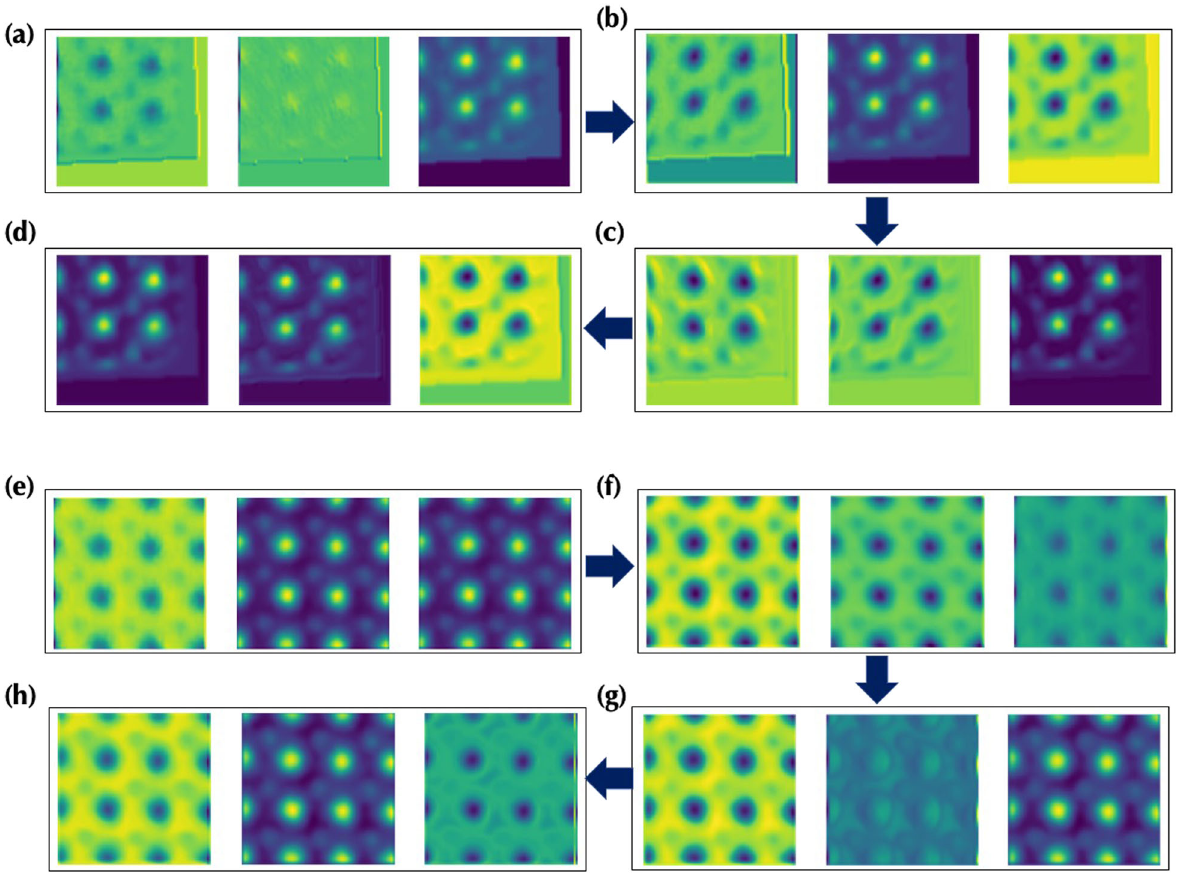
Fig. 5 Feature maps of CNN layers. Representative feature maps for three different fi lters of the fi rst four convolution layers of DCNNs trained on sub-images of 0% Sm-doped BFO are shown. The fi rst block a – d corresponds to the network trained with C while the bottom block e – h refers to another model trained with